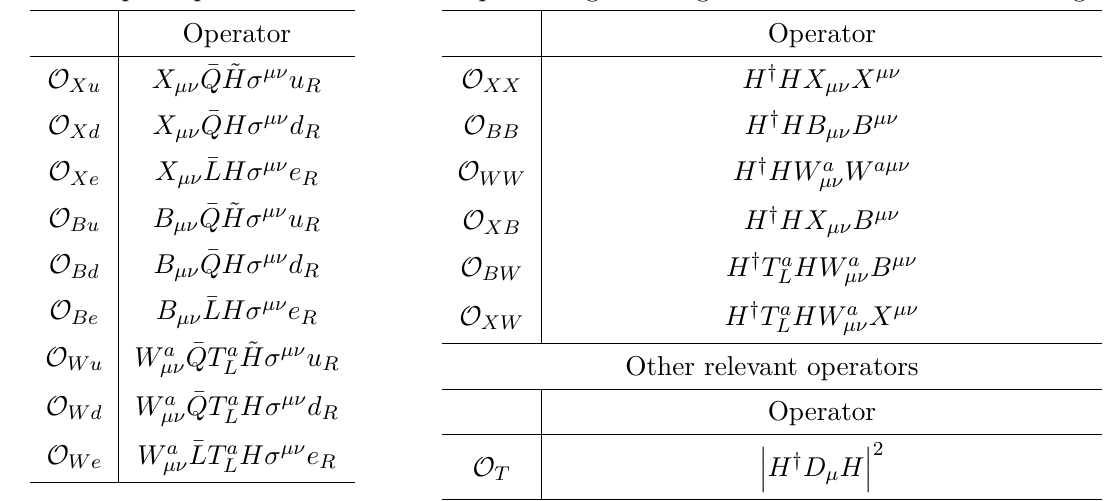
Table 1 . Operators considered in this work. We use the standard notation for the SM states, while the gauge boson associated with the U(1) SU(2) generators normalized as Tr [ T a L